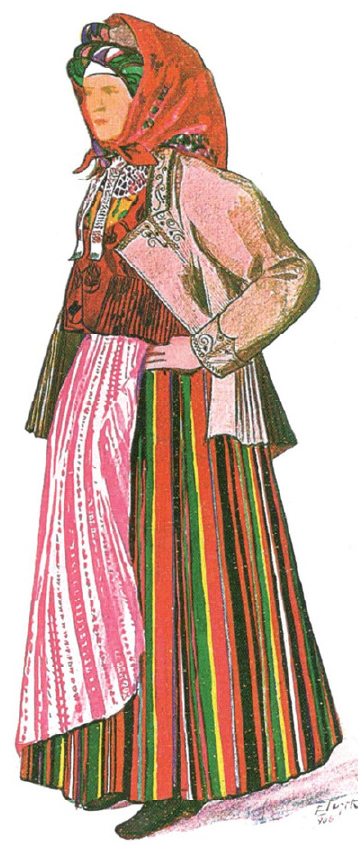
Figure 12. Samogitian woman [61].